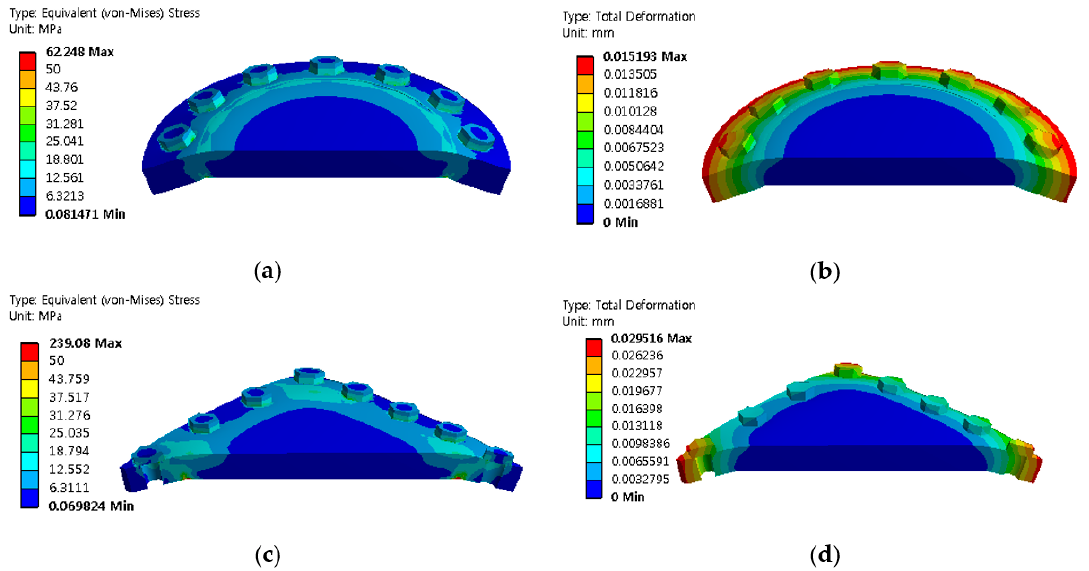
Figure 3. ( a ) Equivalent stress (MPa) and ( b ) total deformation (mm) of the conventional circular end plate; ( c ) equivalent stress (MPa) and ( d ) total deformation (mm) of the conventional square end plate.